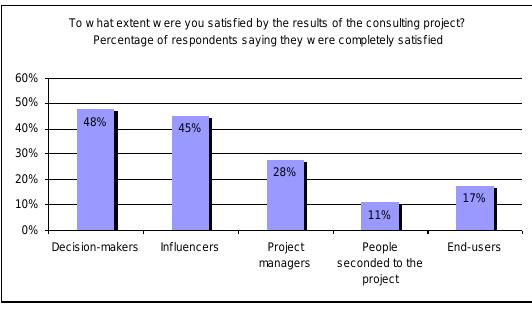
Figure 1 : Satisfaction Levels Fall as You Go Down the Project